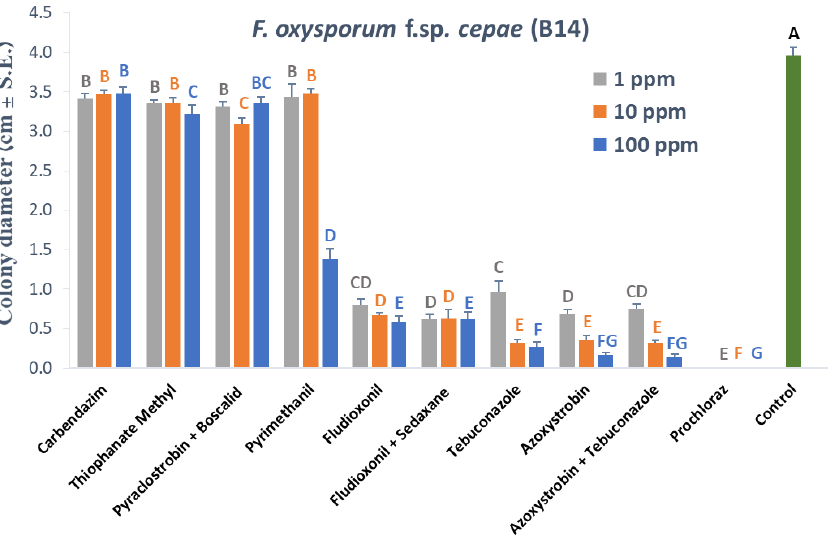
Figure 2. Effect of selected fungicides on the development of Fusarium oxysporum f. sp. cepae (isolate B14) in culture media. The experiment was conducted as described in Figure 1. The columns represent an average diameter of six replications, error lines represent a standard error. Different letters above the columns represent a significant difference ( p < 0.05) in the ANOVA test.